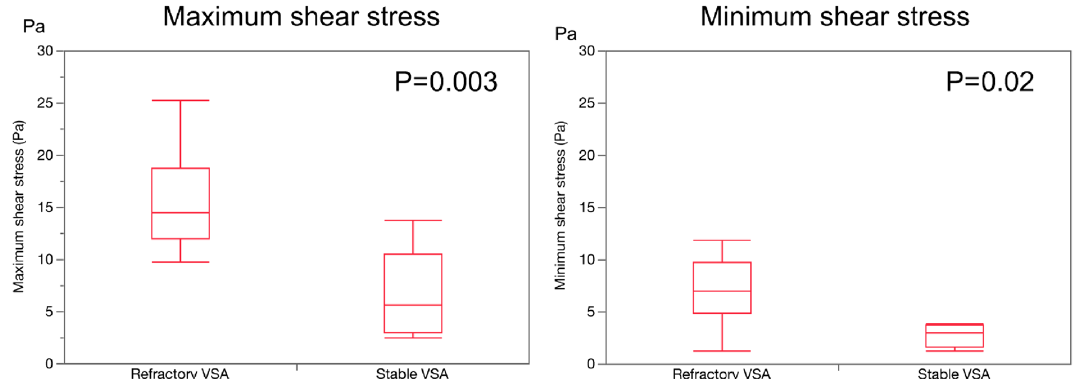
Figure 3. Maximum and minimum shear stress. The left panel presents maximum shear stress and the right panel shows minimum shear stress of both groups. The maximum shear stress in the refractory VSA group was higher than that in the stable VSA group (refractory VSA 14.5 [12.1–18.8] Pa vs stable VSA 5.6 [3.0–10.5] Pa, p = 0.003). The minimum shear stress was also higher in the refractory VSA group compared to that in the stable